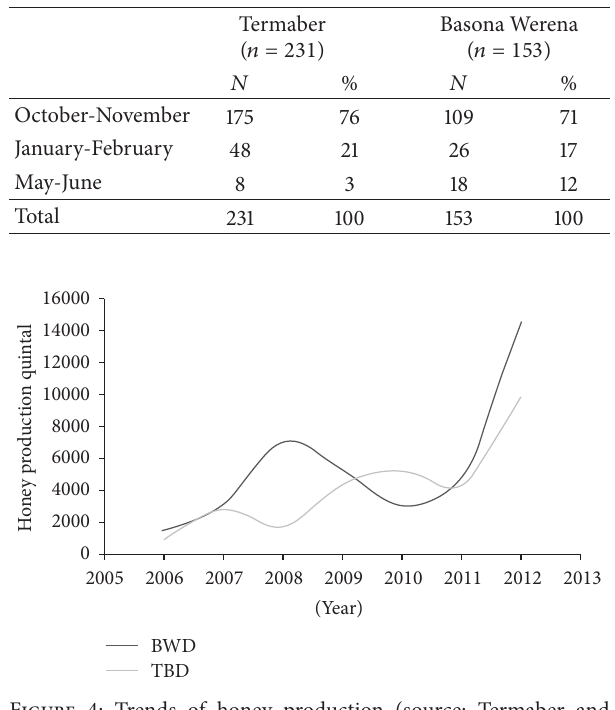
Figure 4: Trends of honey production (source: Termaber and Basona Werena Agriculture Office, 2014).